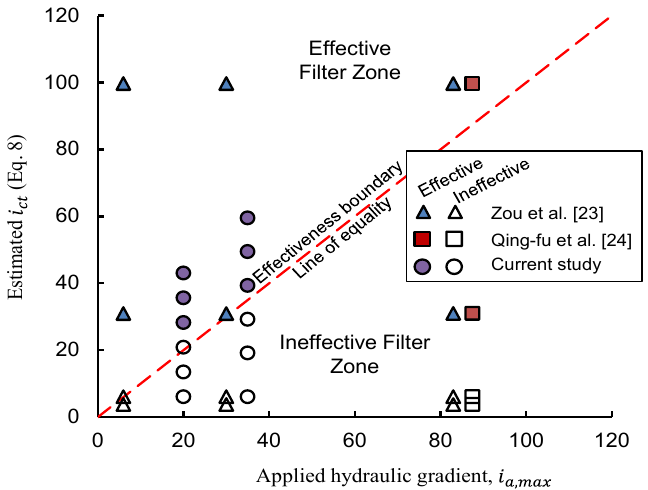
Figure 8. The comparison between observed and estimated i cr values by the proposed model for numerical modeling data in Table 2.